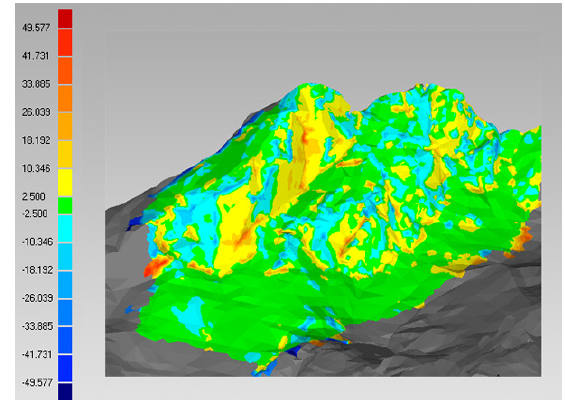
Figure 5. Comparison of laser scanning-based model and standard DTM